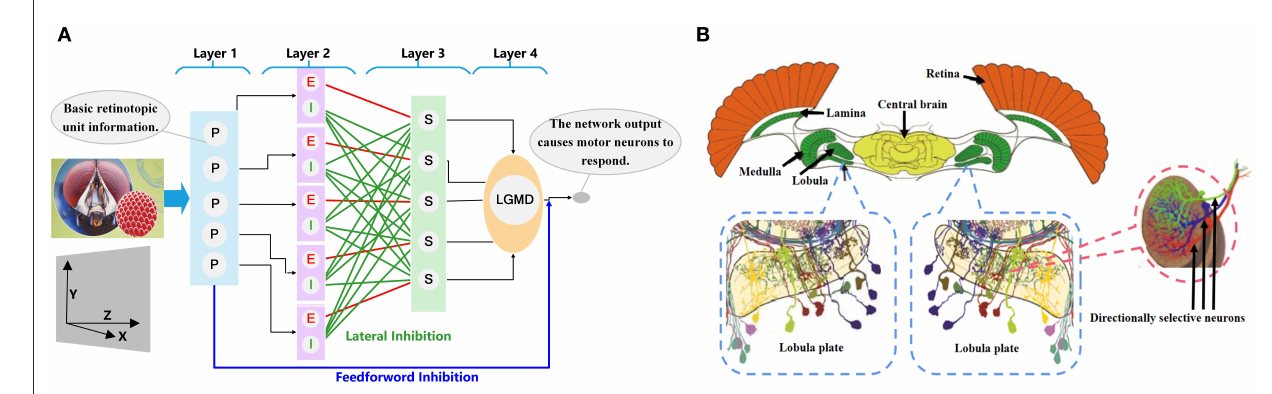
FIGURE1 The insect neural system. (A) Neural network of LGMD neurons. The neural network is composed of four retinotopically organized layers. (B) The biological vision system of insects [modified from Haag and Borst (2002) and Borst et al. (2020)]. The directionally selective neurons are located on the lobular plate, and sense the direction information of